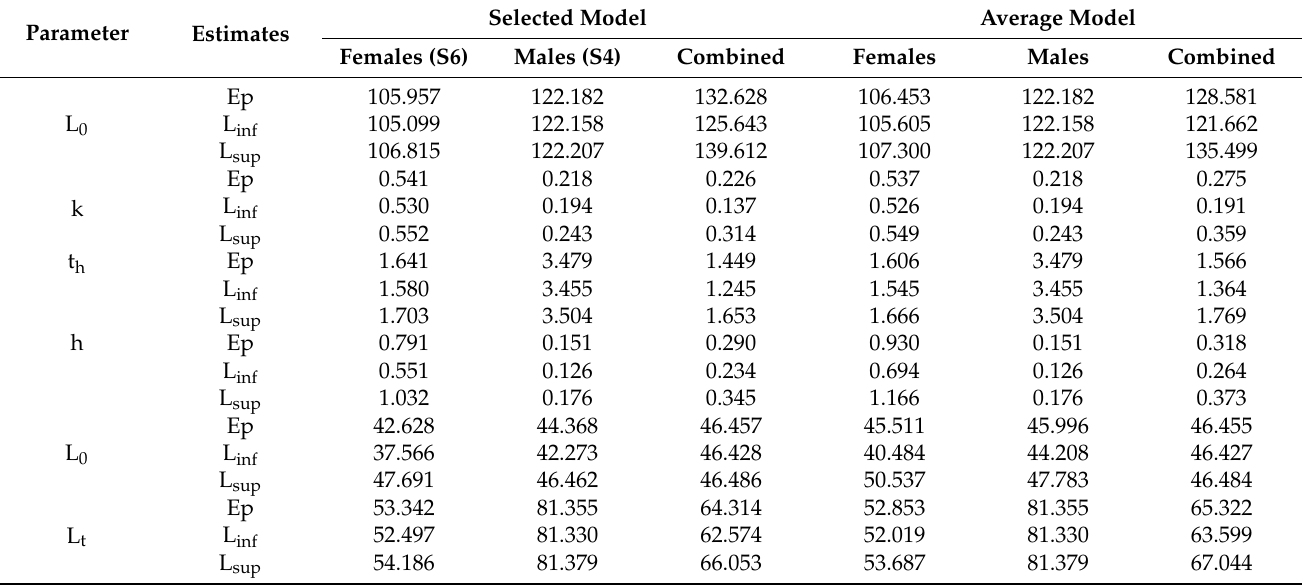
Table 5. Point estimates and confidence intervals of the growth parameters for the selected models and average models of the bonnethead shark ( Sphyrna tiburo ) in the western Gulf of